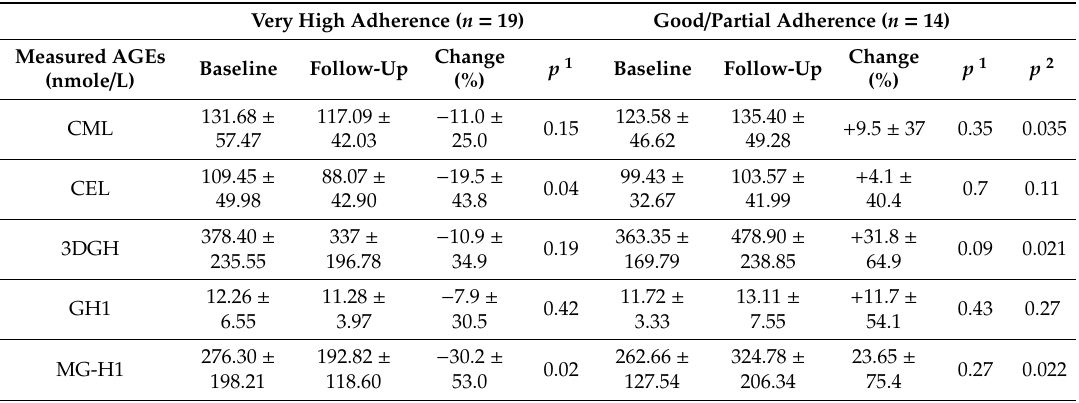
Table 5. Mean change in AGEs levels between baseline and 6 months follow-up by level of adherence to the dietary instructions (AGEs-lowering arm). Very High Adherence ( n =